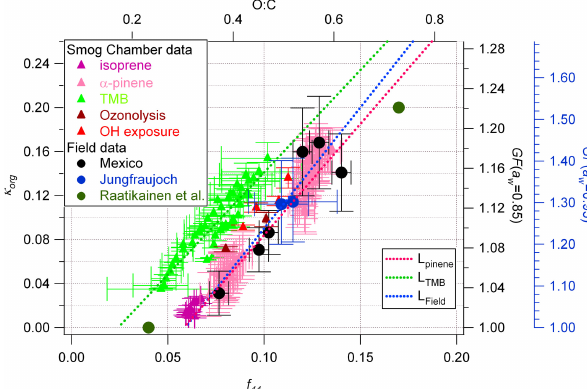
Fig. 6. Result from the screening multiple linear regression of all smog chamber data sets, with f 44 as the first input variable. Choos- ing f 30 or f 46 or f 55 as first input variable for the screening regres- sion results in the same four f x being selected by the procedure (not shown).